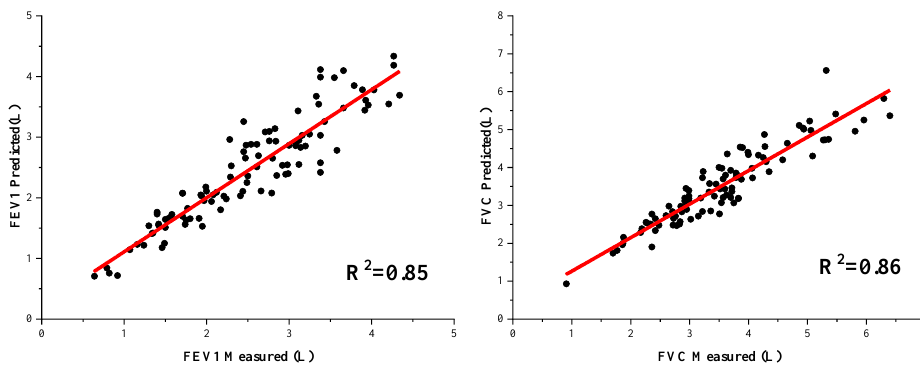
Figure 12. The fitting curves of the combination algorithm results.